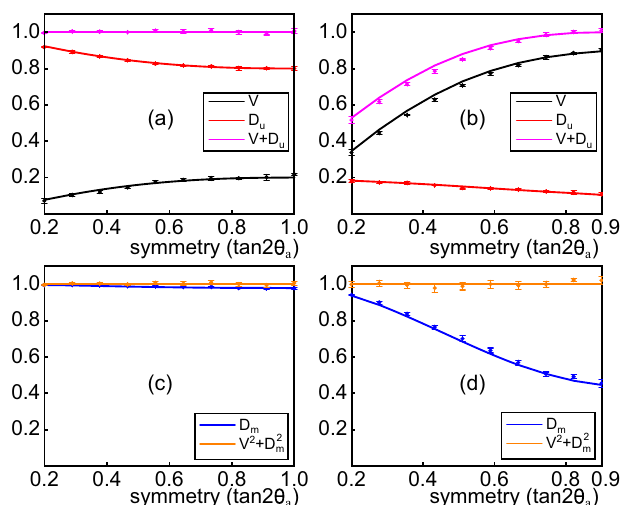
Fig. 5 Experimental results. Duality relations when the nonortho- gonality of the fi nal states of the WWD is ( a , c ) sin2 θ n ¼ 0 : 2 and ( b , d ) sin2 θ n ¼ 0 : 9 . ( a , b ): Con fi rmation of the linear duality relation. ( c , d ) Con fi rmation of the quadratic duality relation. The experi- mental visibility in ( c , d ) is the same as that in ( a , b ), both are calculated through Eq. (14). The label symmetry signi fi es the symmetry of the interference and it is quanti fi ed by tan2 θ a . The dots are experimental values while the solid lines are theoretical values. The error bars indicate one standard deviation.